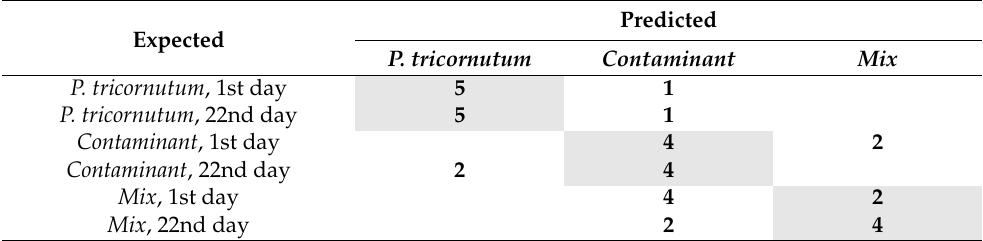
Table 2. PLS-DA confusion matrix of P. tricornutum, Contaminant, and Mix cultures classification obtained by cross validation